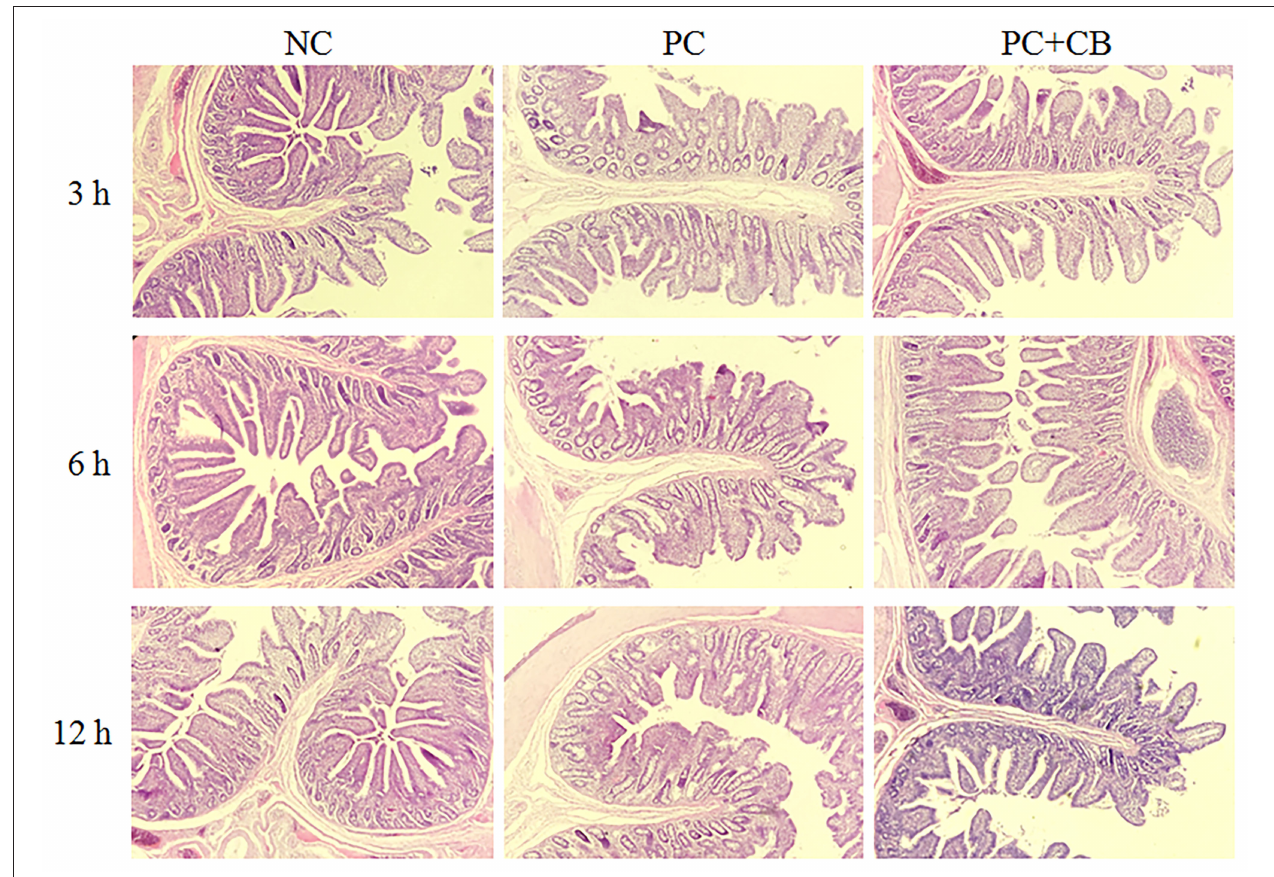
FIGURE 2 | Effect of CB on the jejunal morphology of piglets. Pigs were challenged with or without ETEC (1 × 10 9 CFU/kg BW). At 3, 6, and 12h post inflammatory challenge, jejunal samples were collected for histopathological examination. NC, piglets were fed the daily diet and received oral administration of sterile physiological saline; PC, piglets were fed the daily diet and received oral challenge with ETEC K88; PC + CB, piglets were fed the CB-supplemented diet and received oral challenge with ETEC